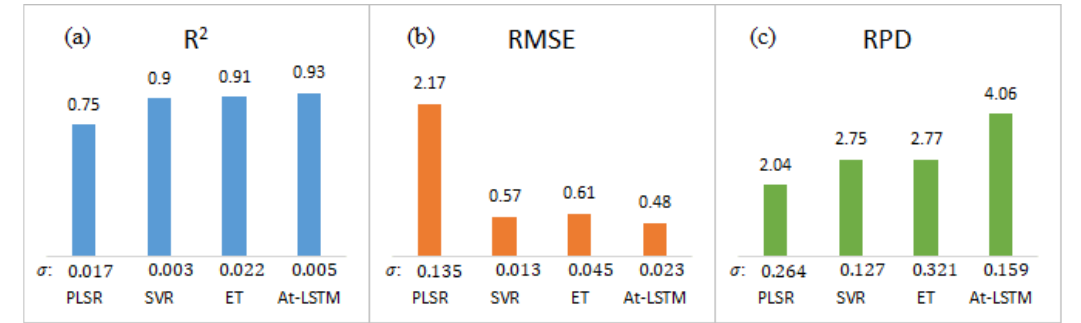
Figure 7. Comparison of evaluation indexes of prediction; ( a ) R 2 , ( b ) RMSE , and ( c ) RPD of PLSR, SVR, ET, and attention- based LSTM model (σ: standard deviation of cross-validation prediction).